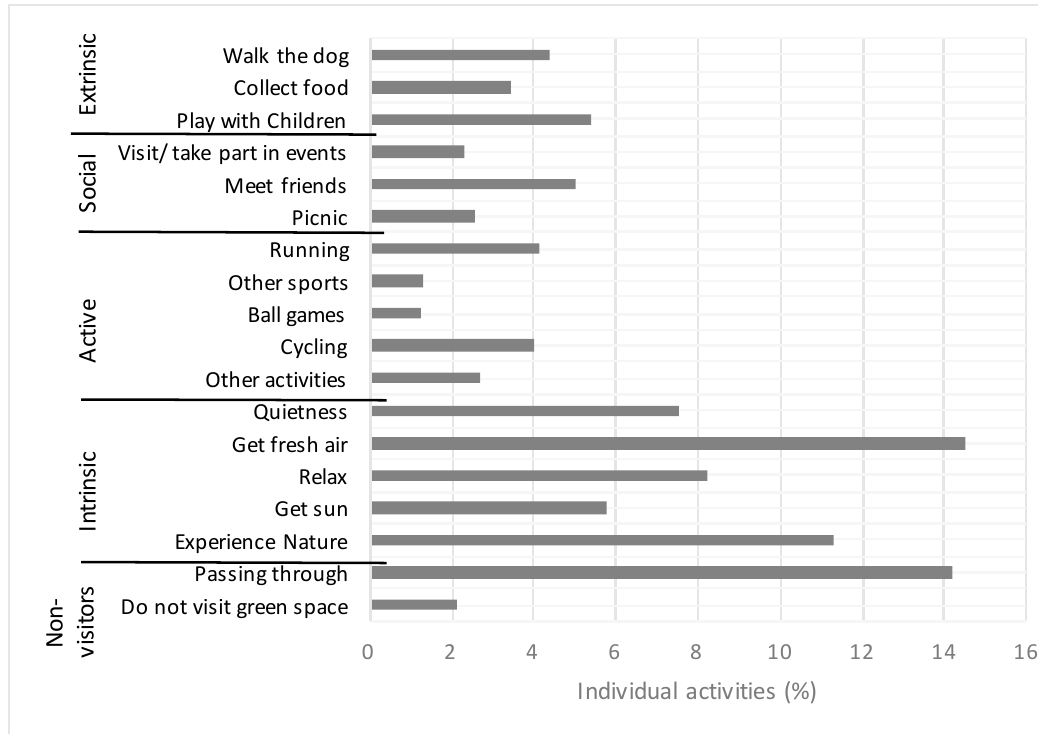
Figure 1. Percentage of activities for the different groups of motivating factors based on a study of 1010 adult Norwegians.